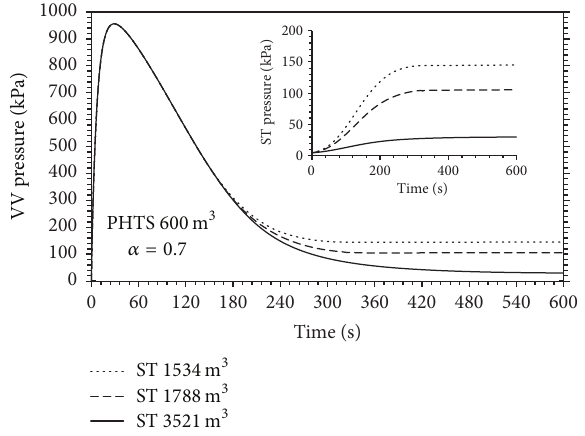
Figure 5: Sensitivity analysis on the PHTS volume. Figure 6: Sensitivity analysis on the ST volume.